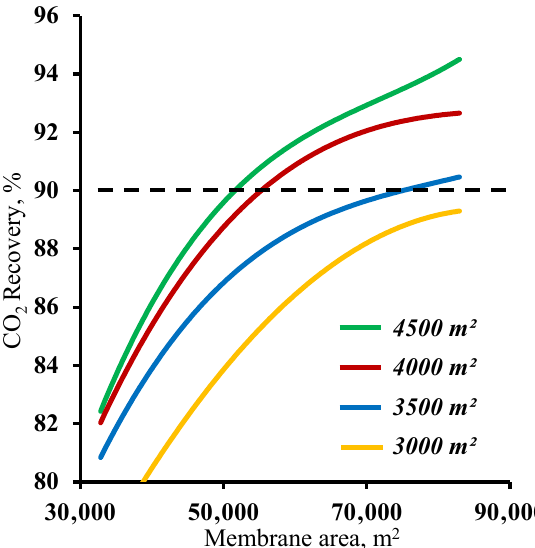
Figure 5. Dependence of carbon dioxide recovery rate on the membrane area in the stripping section (M1) for four different fixed membrane area values in the enrichment section (M2 and M3).